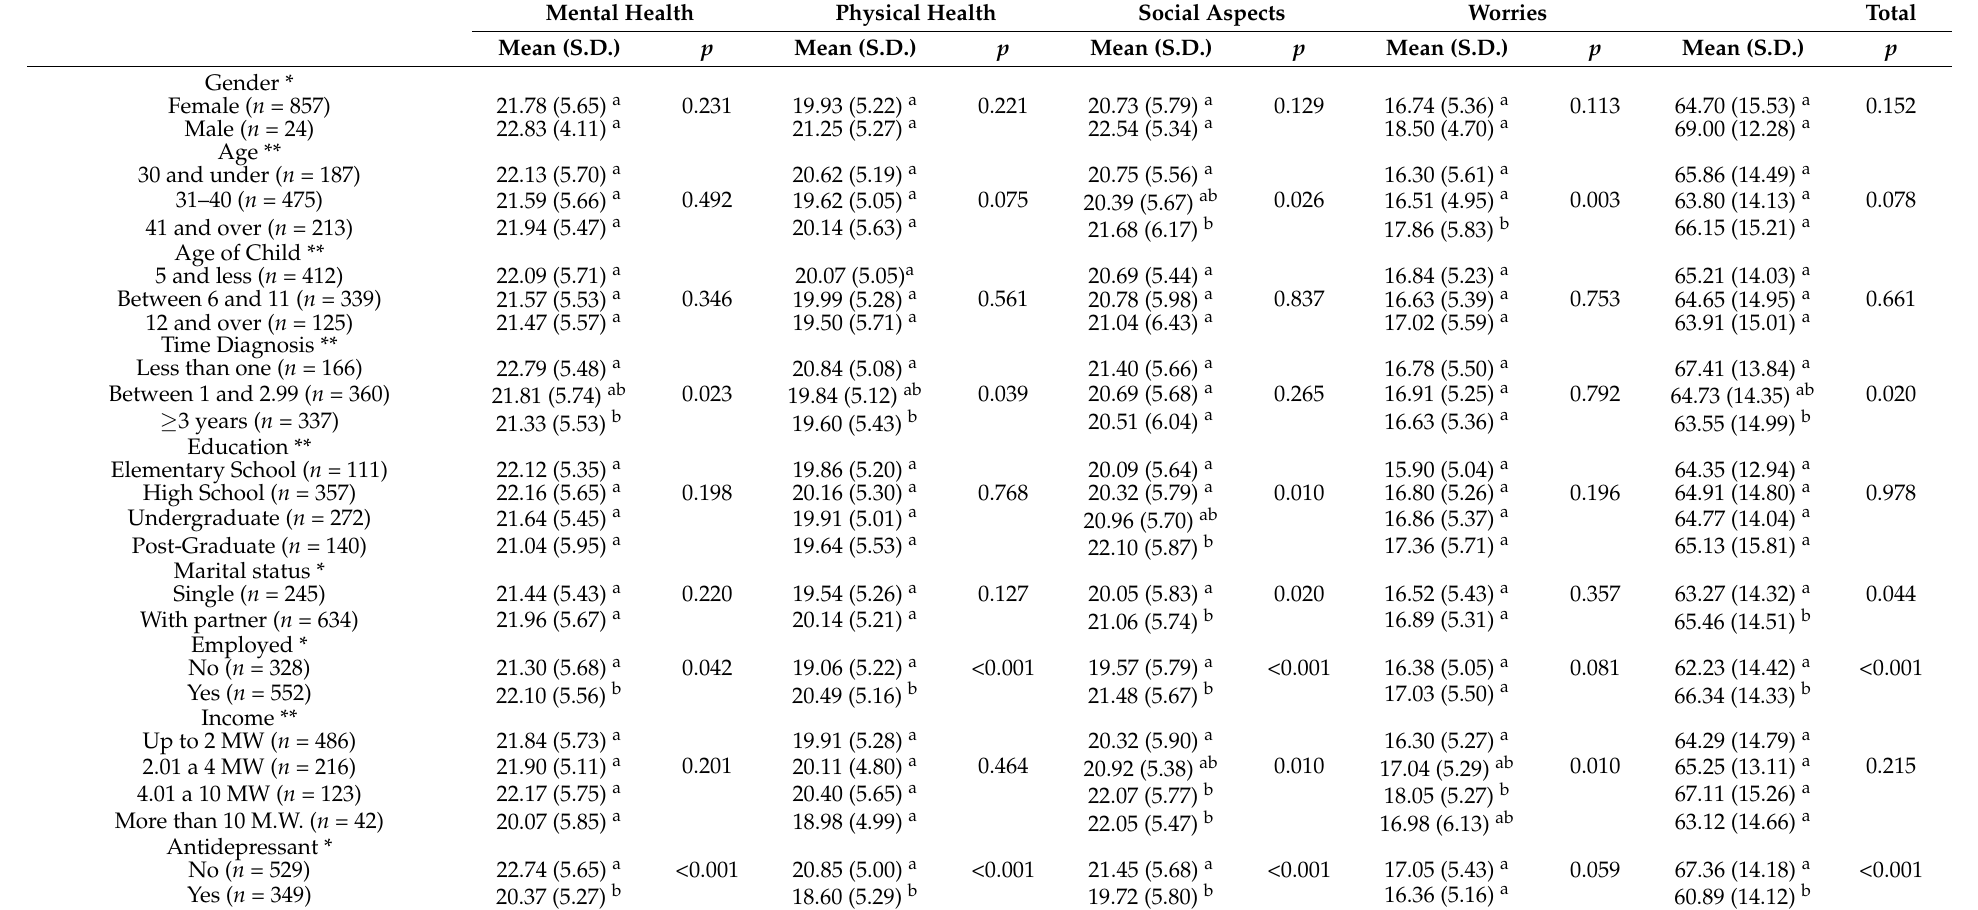
Table 3. Mean (M), standard deviation (S.D.), and p -value of comparison of ASDPCA-QoL questionnaire scores (and their domains) according to study variables ( n = 881). Mental Health Physical Health Social Aspects Worries Total Mean (S.D.) p Mean (S.D.) p Mean (S.D.) p Mean (S.D.) p Mean (S.D.)